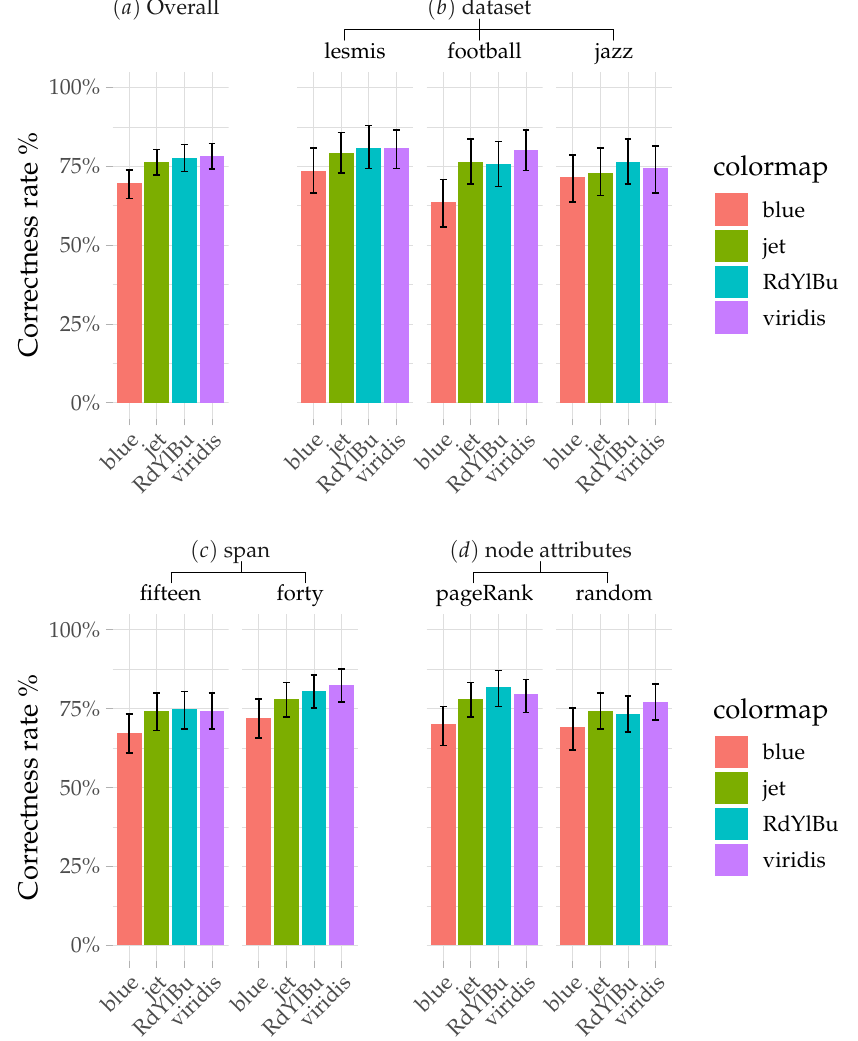
Figure 4. Results of the experiment for the correctness rate . ( a ) shows the overall correctness rate for each colormap , which is then broken down further into datasets ( b ), span ( c ), and node attributes ( d